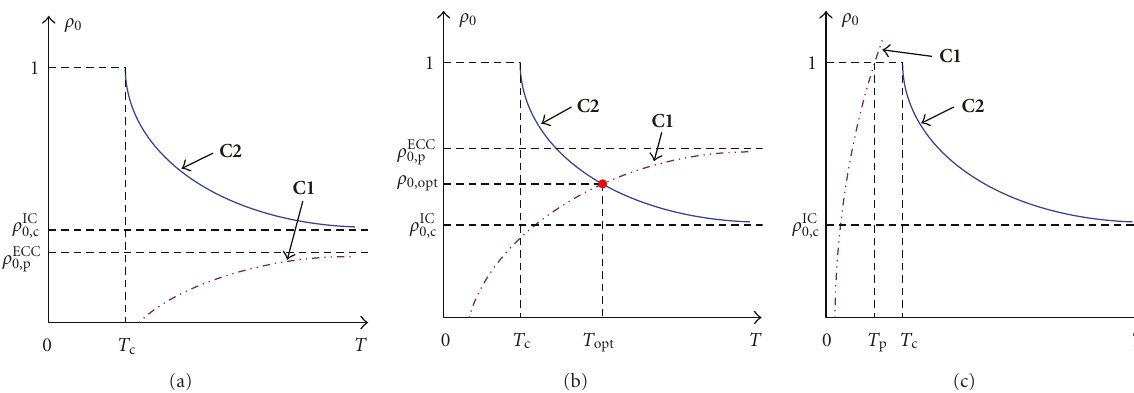
Figure 2: Illustration of the relationship of IC and ECC under access policy π 1 . C1 and C2 are the curves when ECC and IC hold with equality,